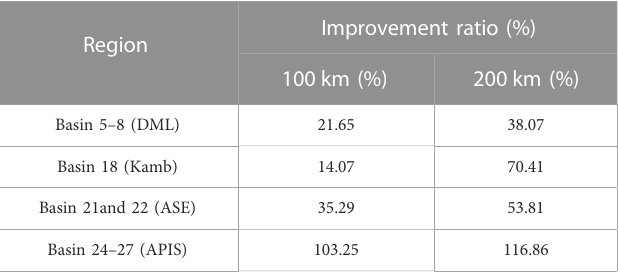
TABLE 4 Improvements for the mass change